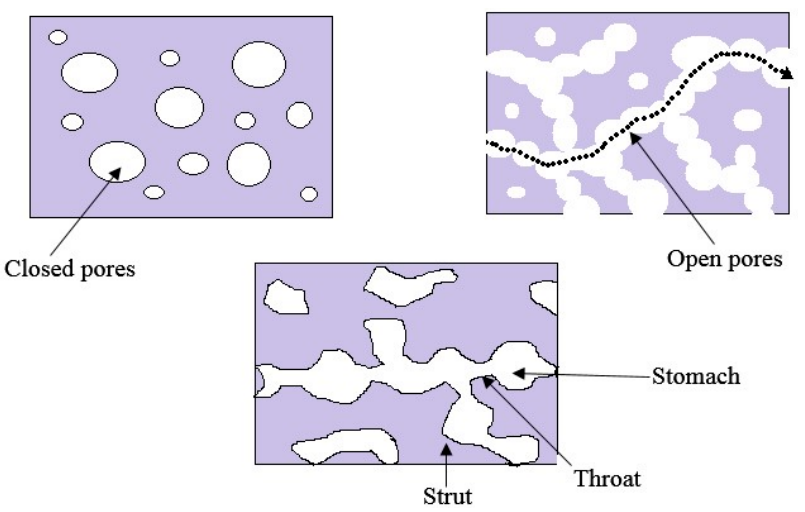
Figure 1. Porous features of porous biomaterial.